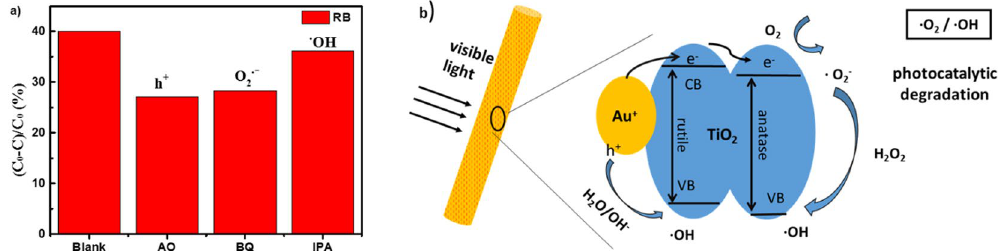
Figure 6. ( a ) Effect of a series of scavengers on the degradation efficiency of RB for Au(10)/TiO2 nanofibers. Blank, Ammonium Oxalate (AO), Benzoquinine (BQ), Isopropanol (IPA) (Illumination time t = 150 min). ( b ) The photodegradation mechanism schematic illustration of the Au/TiO 2